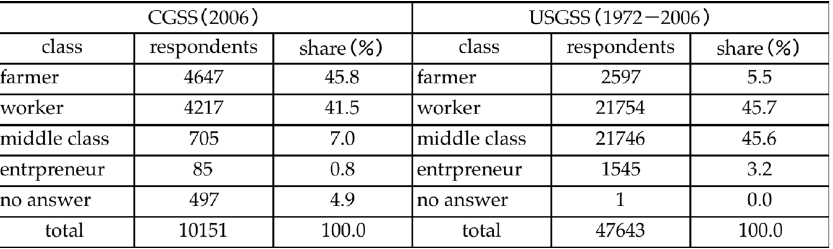
Table 1. Class recognition (self